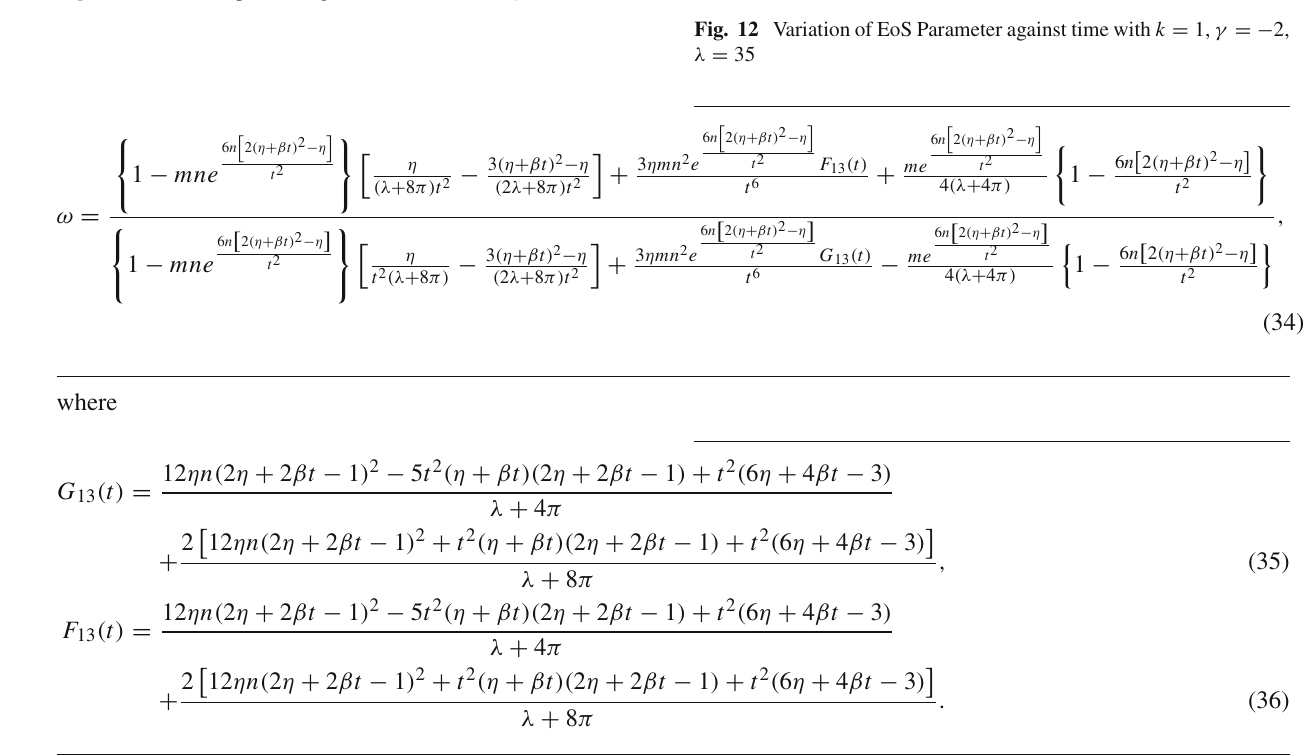
Fig. 10 Variationofpressureagainsttimewith k = 1, γ = − 2, λ = 35